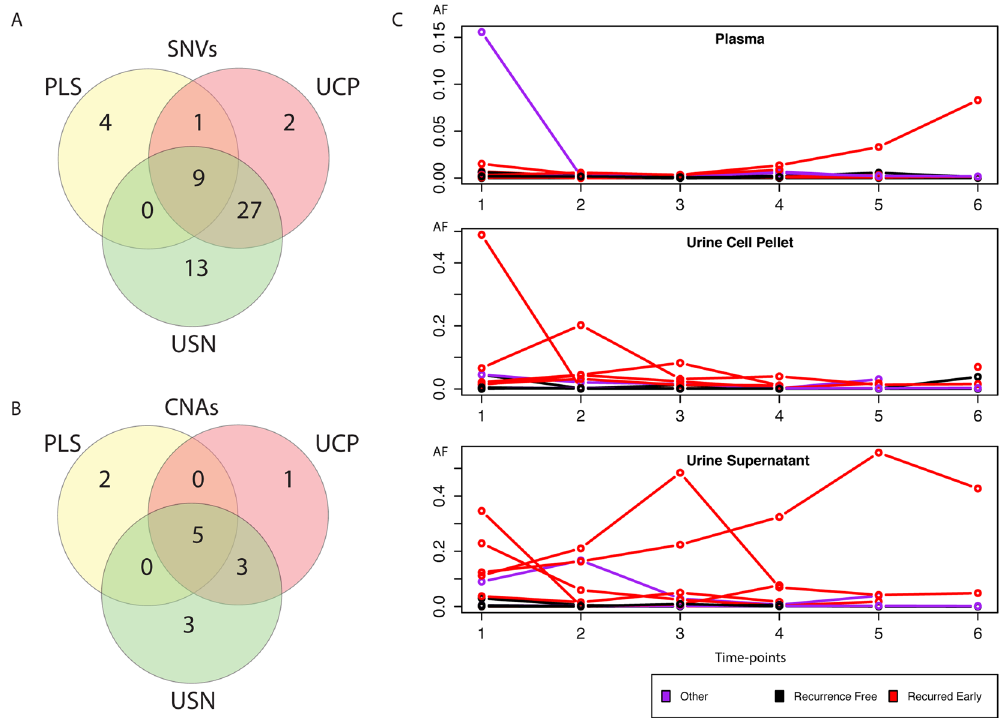
Figure 4. Longitudinal analysis of peripheral samples for non-invasive detection of tumour profiles in MIBC. ( A + B ) Venn diagrams demonstrating that more SNVs ( A ) and CNAs ( B ) were detected in the urine, as compared to the plasma samples. The number of times SNVs or CNAs were detected in peripheral samples per time-point (where all three peripheral samples were collected) were depicted as Venn diagrams. 52 out of 56 SNVs and 12 out of 14 CNAs were detected in urinary samples. However for SNVs, 4 mutations/time-points were detected only in PLS, 2 in UCP and 13 in USN. For CNAs 2 mutations/time-points were detected only in PLS, 1 in UCP and 3 in USN, confirming that multiple sample analysis can improve mutDNA detection in MIBC. ( C ) Maximum mutDNA AF during NAC demonstrates differing kinetics in PLS, UCP and USN. Three plots depict the maximum SNV AF at each time-point in PLS, UCP and USN samples for 13 patients with detected SNVs. There are clear differences in the AF kinetics between the peripheral sample types. Generally levels are low in PLS while AFs rise and fall dynamically in urinary specimens. For most patients, mAFs are low during NAC, however, mAFs that were considerably higher than the 0.005 AF detection threshold were found in patients that